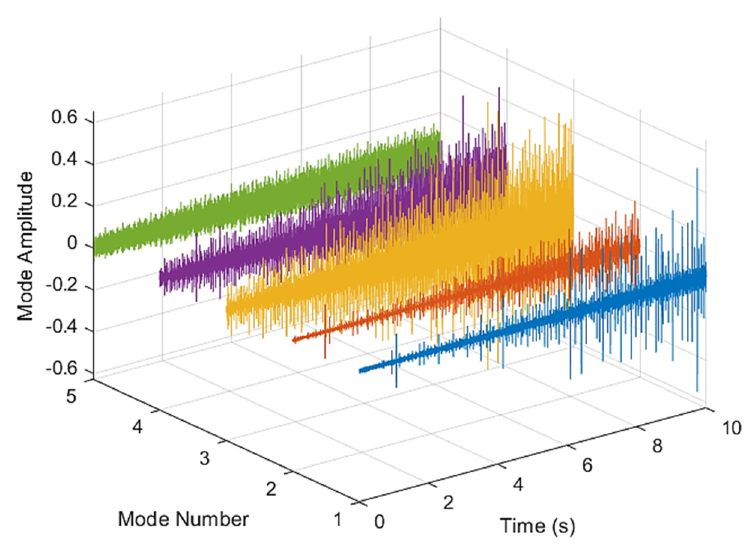
Figure 5. VMD analysis from an inner race fault bearing under increasing rotational speed condition in time domain.